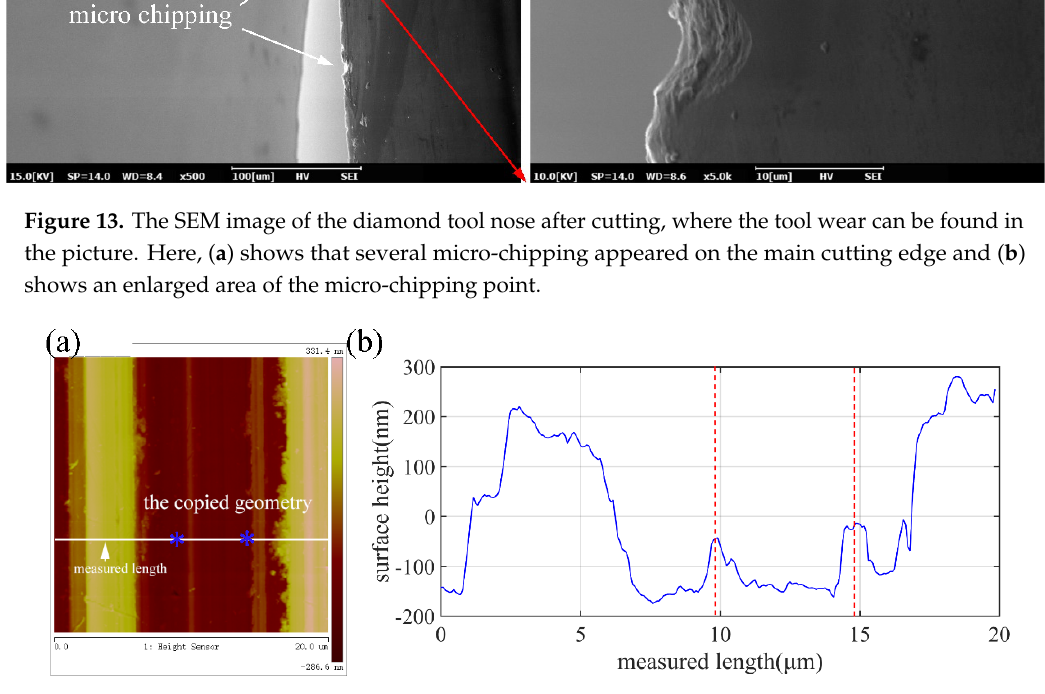
Figure 14. The atomic force microscope (AFM) measurement result of the machined surface. Here, ( a ) is the machined surface and ( b ) is the picked measured length.